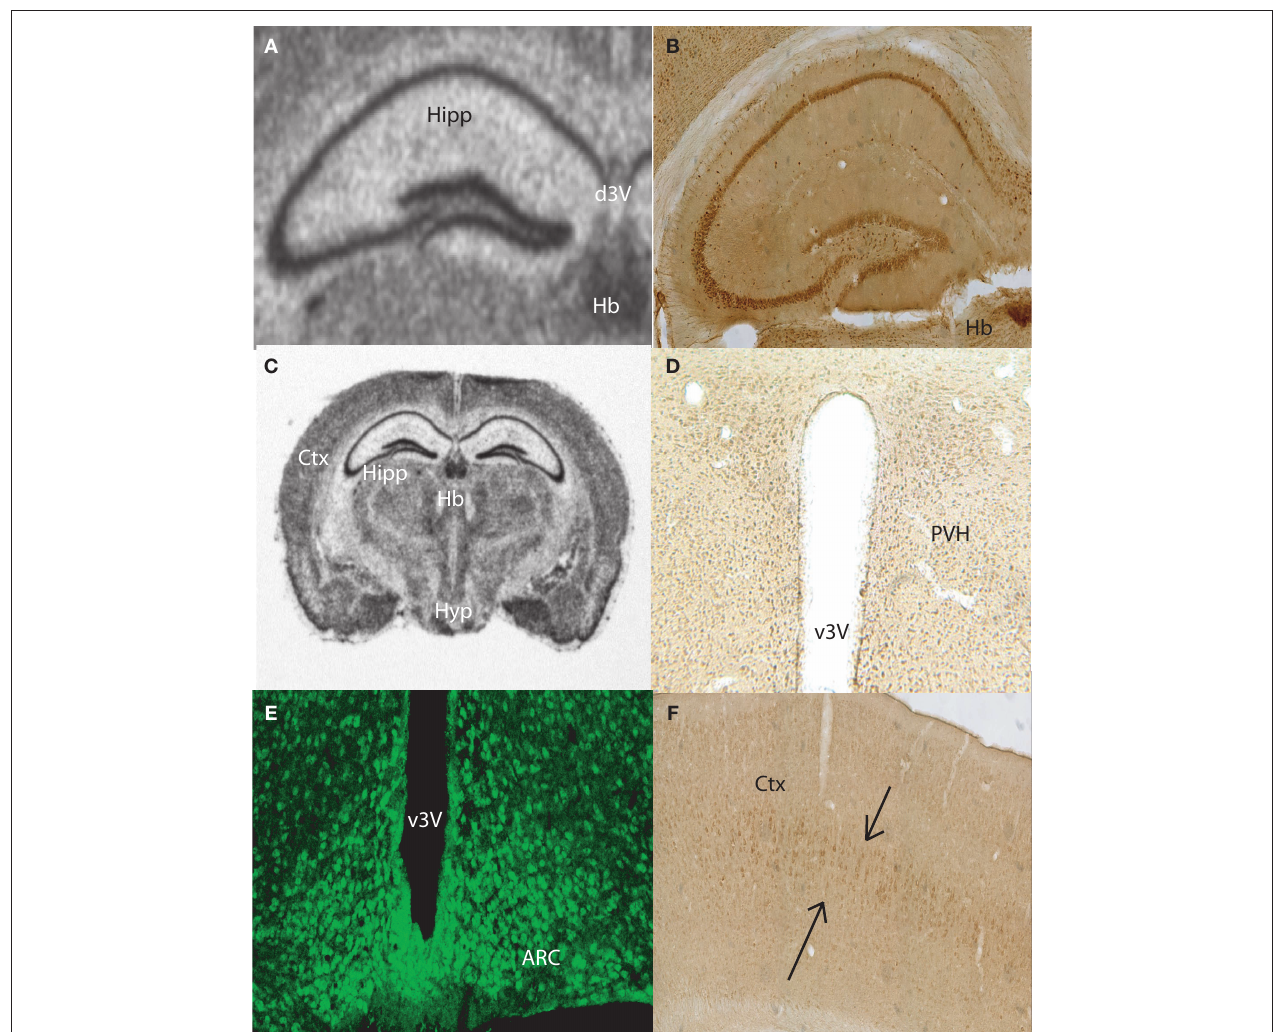
FIGURE 3 | Anatomical distribution of the gene Tas1r3 , and of its product, the taste receptor subunit T1R3. Images from the mouse hippocampus, hypothalamus and cortex obtained from both in situ hybridization and DAB immunolabeling methods were placed alongside. (A) Tas1r3 and (B) T1R3 expression in the hippocampus. Note the strong levels of both gene and protein expression on the CA fi elds and dentate gyrus, further demonstrating the preferential expression of taste-related elements in neurons. Note also the proximity of the hippocampus to the lateral ventricle. (C) Overall view of a brain section hybridized against a Tas1r3 probe. Note the high levels of expression in hippocampus, hypothalamus, cortex and habenula. ISH also identifi ed Tas1r3 expression in the epithelial cells of the choroid plexus.